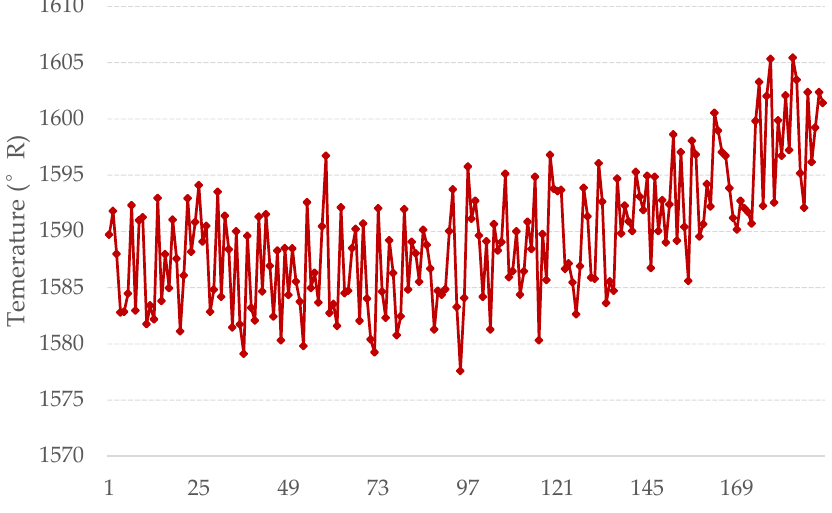
Figure 9. Outlet temperature of high-pressure compressor.